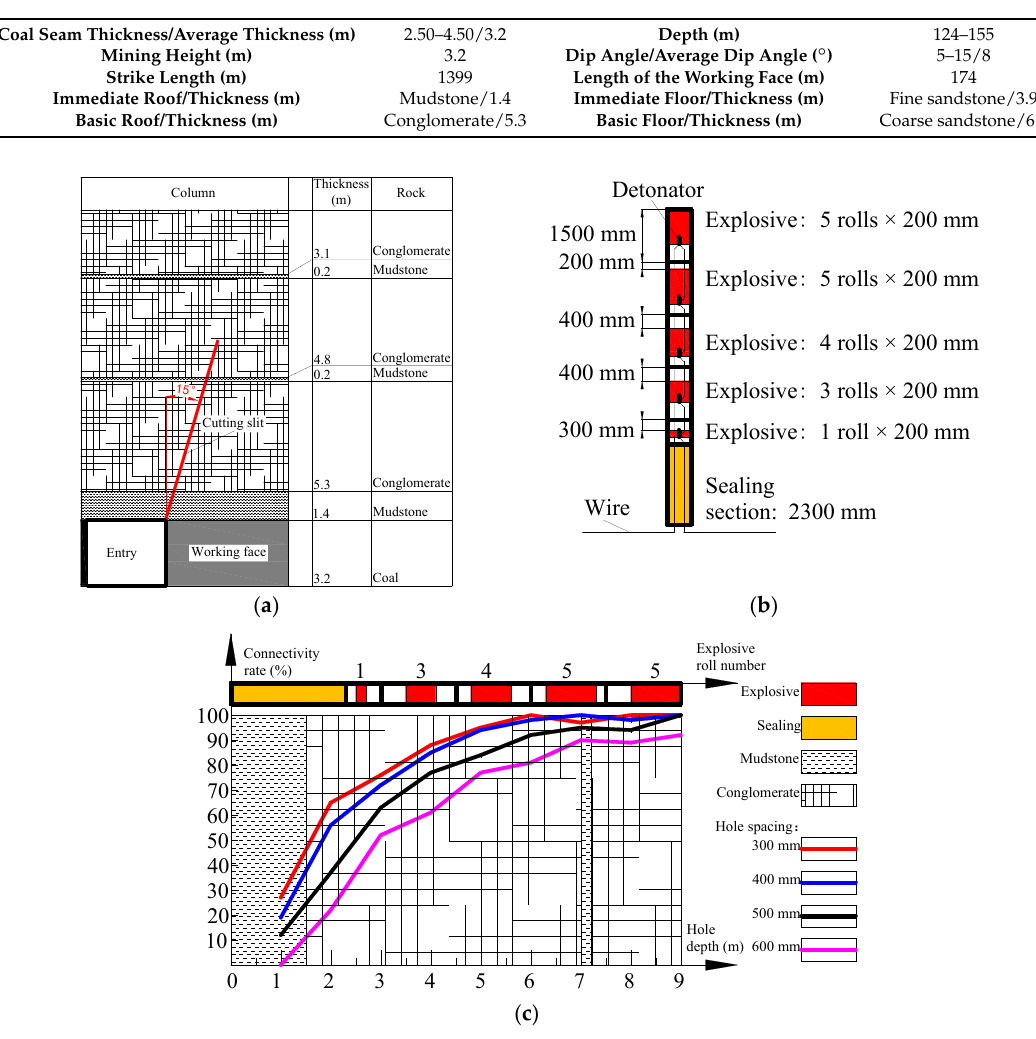
Figure 10. Roof cutting blasting design of the W1-106 working face: ( a ) roof cutting design; ( b ) schematic of charge structure; ( c ) statistical drawing of roof cutting connectivity rate.